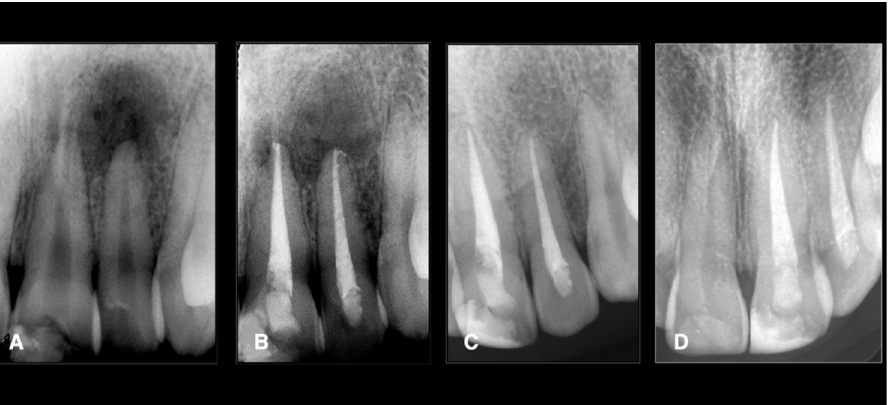
Figure 2. Endodontic treatment of a second maxillary left incisor. The tooth was necrotically associated with periapical lesions. The treatments were done using conservative shaping and the 3D cleaning procedure, as mentioned in the Materials and Methods. ( A ) Preoperative X-ray, ( B ) postoperative X-ray, ( C ) 1-year follow-up, ( D ) 2-year follow-up showing healing. Incidence of